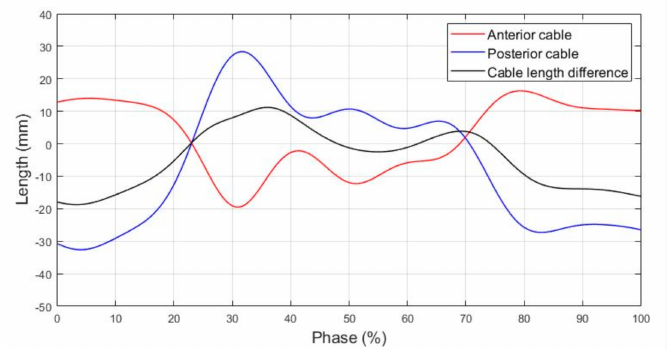
Figure 5. The changes in cable length were calculated based on the rotation angle of the talocrural joint and subtalar joint in Figure 3b. Observing the black line, the posterior cable has a longer length change than the anterior cable.